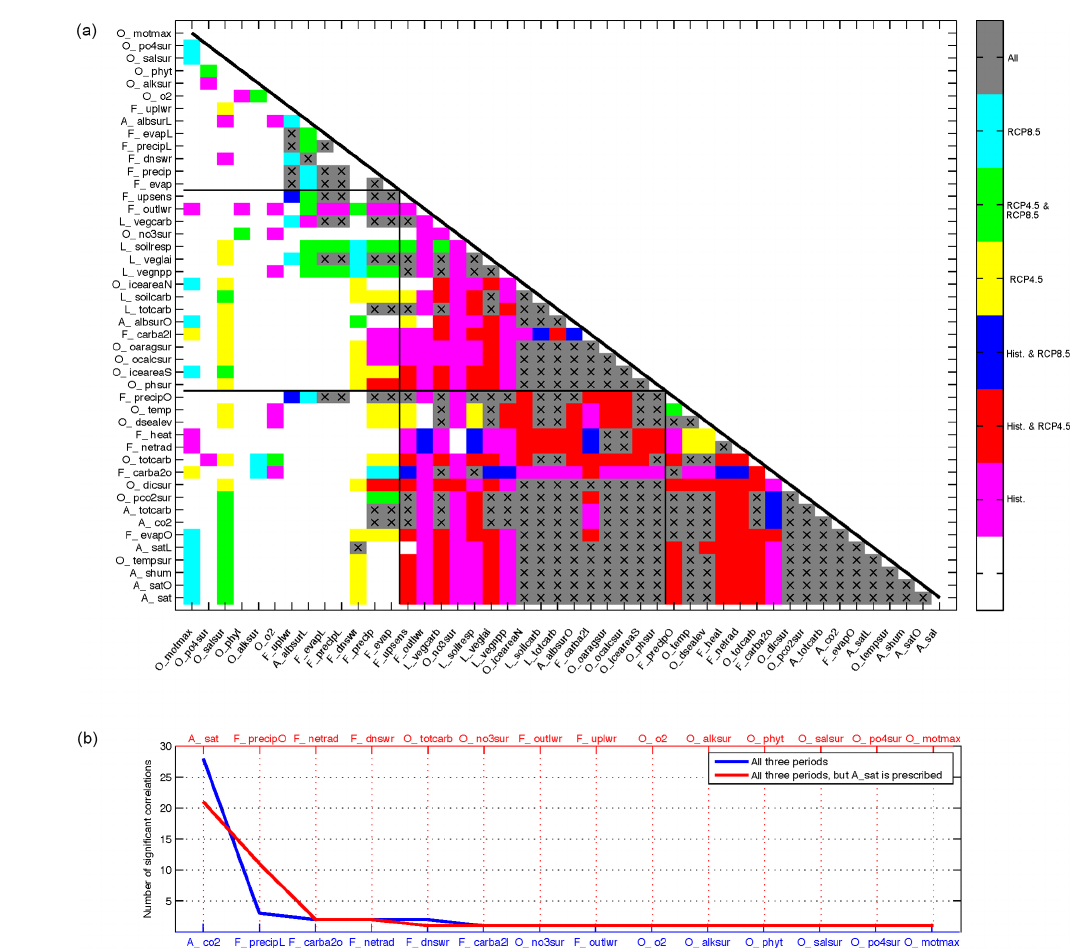
Figure 5. (a) Correlation matrix for all three scenarios, merging the significance information from all three scenarios. Colors indicate in which scenario the changes in variables due to parameter perturbations showed a significant correlation; see color bar for an explana- tion. The crosses mark combinations of variables where the correlation of variable changes is significant at a 5% significance level in all three scenarios. For details on the model output variables under consideration, see Table A1. (b) Indicators as identified from the anal- ysis based on the correlation matrix above against the number of significant correlations (blue) and with the condition that “surface air temperature” (A_sat) is prescribed as the first indicator (red). The indicators are as follows: “atmospheric carbon content” (A_co2), “precip- itation over land” (F_precipL), “atmosphere-to-ocean carbon flux” (F_carba2o), “net top-of-atmosphere radiation” (F_netrad), “net